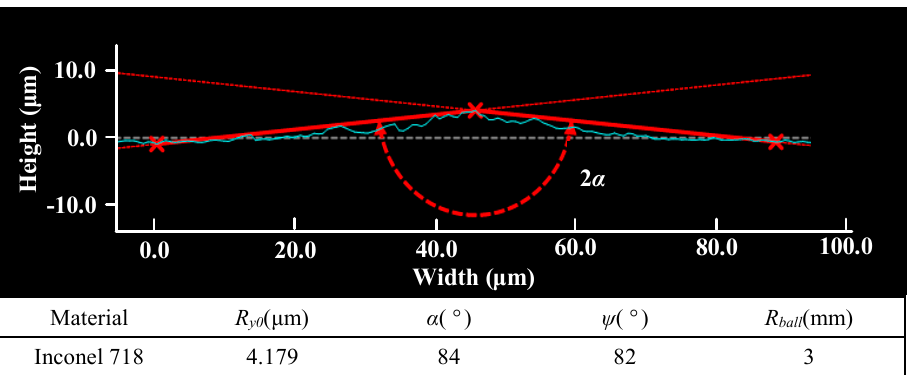
Figure 11. Surface roughness peak simplification and geometric parameters measurement. (The blue line is the measured surface roughness peak. The red line is the simplified wedge. The red dot line indicate the wedge angle).